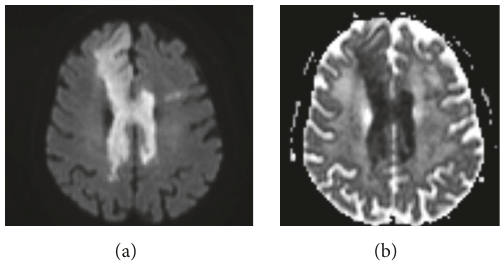
Figure 3: MR diffusion weighted images. DWI (a) and ADC map (b) with significant restricted diffusion of the corpus callosum bilaterally in all the segments and in the right anterior frontal and parietal region.